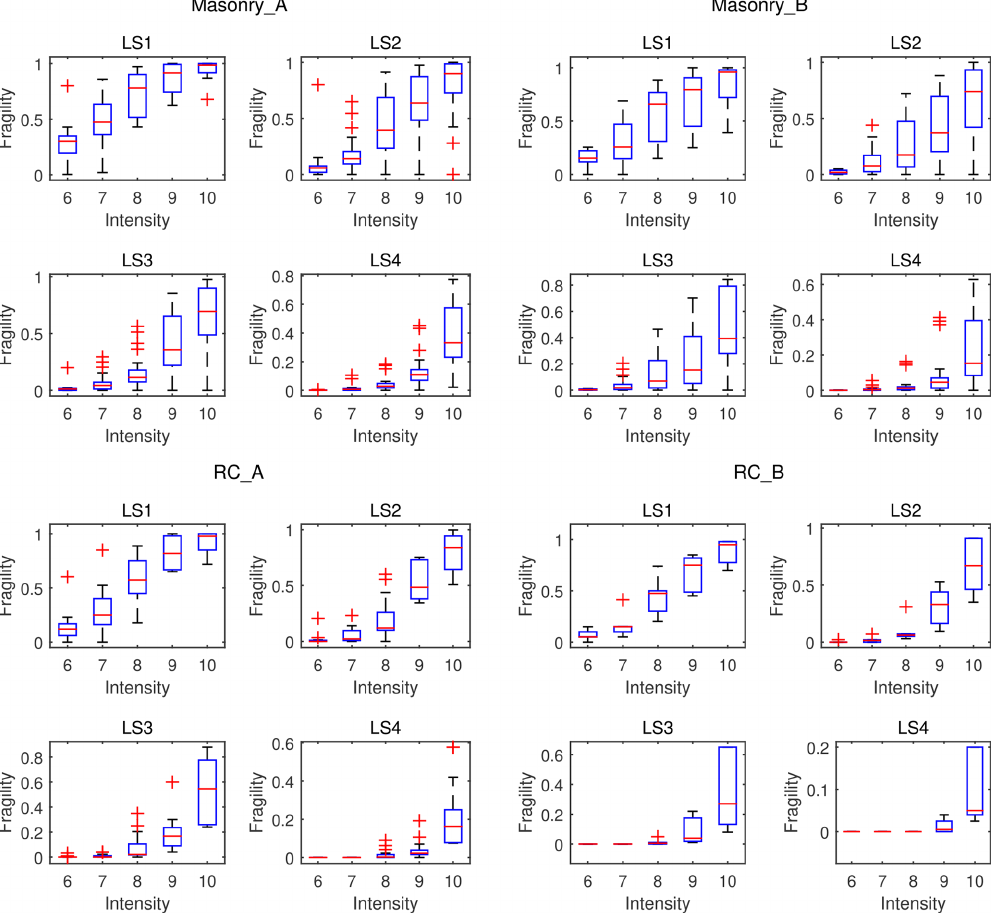
Figure 5. Outlier check using the box-plot method for empirical fragility data. Five macroseismic intensity levels are used to classify the original fragility datasets: VI, VII, VIII, IX, X. “A” and “B” represent the pre-code, low and moderate level and the high seismic resistance level, respectively (more classification details are available in the Supplement). LS1, LS2, LS3 and LS4 are the four damage limit states. Outliers are marked by red crosses, and the red line within each box indicates the 50% quantile fragility value.